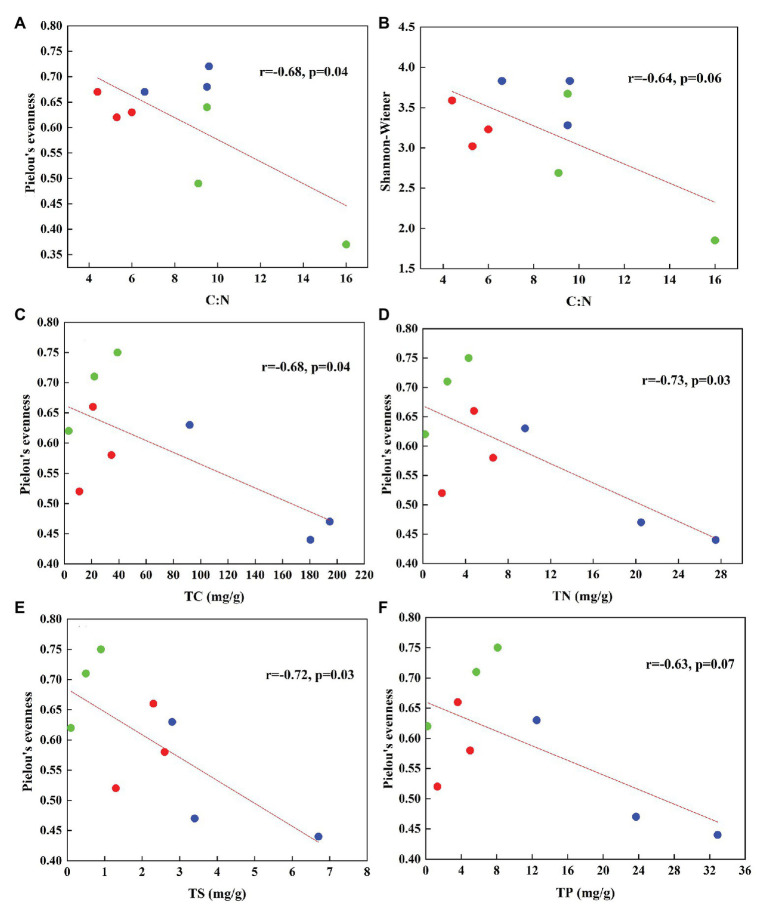
The relationships between the diversity of nirS type (A,B) and nirK type (C–F) denitrifiers and soil biogeochemical parameters associated with sea animal activities in tundra soils of maritime Antarctica (n = 9). The red, blue, and green dots represent the soils from SS, PS, and AL sites, respectively.